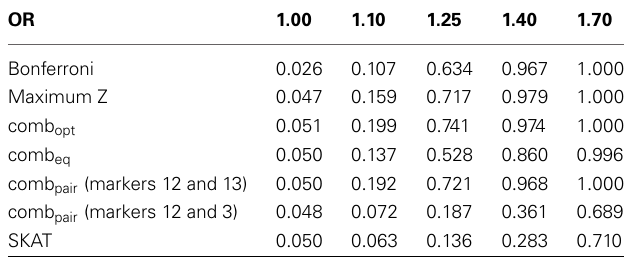
Table 3 | Estimated type-I errors (for OR = 1.00) and power ( OR = 1.10, 1.25, 1.40 and 1.70) for different methods of addressing multiple comparisons in a 24 marker block on chromosome 22, simulated based on genome scans of samples from the Lung Health Study (correlation and LD structure shown in the supplementary